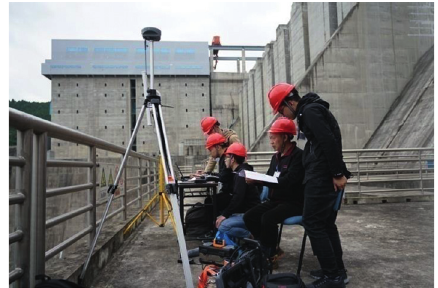
Figure 8: The field working picture of